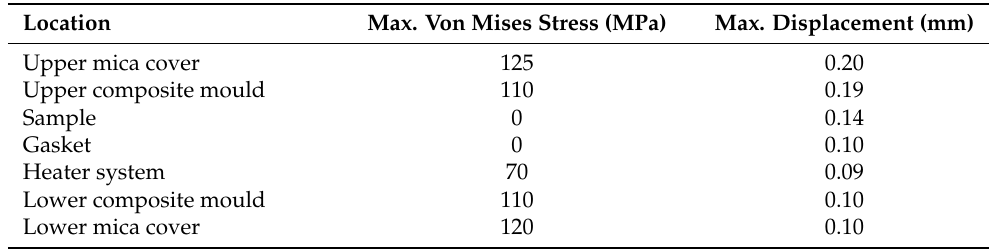
Table 3. Maximum von Mises stresses and